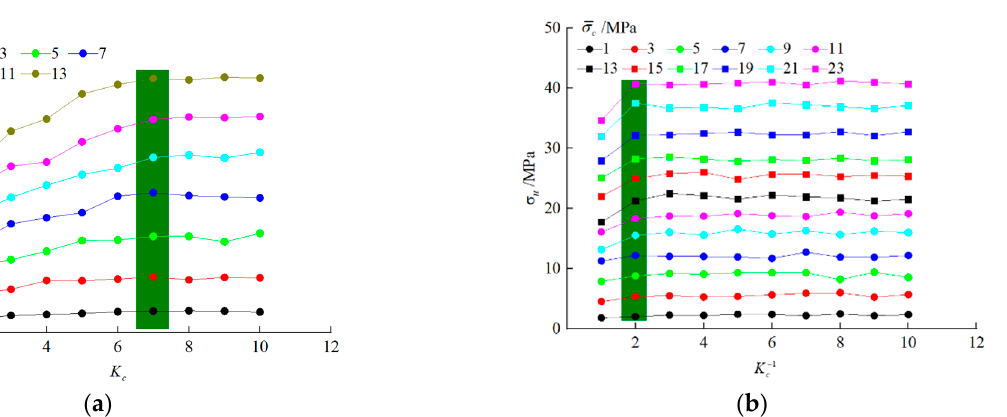
Figure 6. Effects of the bond strength ratio on peak strength: ( a ) tensile-shear bond strength ratio; ( b ) shear-tensile bond strength ratio.